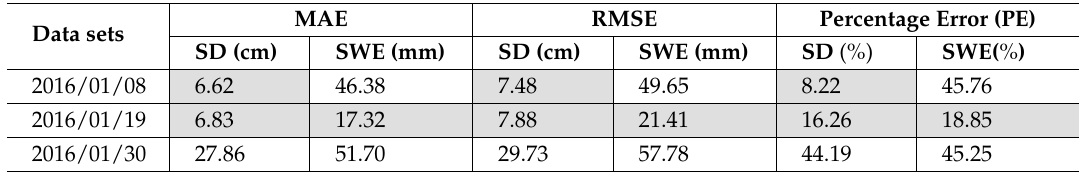
Table 4. Statistical analysis of the retrieved snow depth (SD) and snow water equivalent (SWE), using root mean square error (RMSE) and mean absolute difference